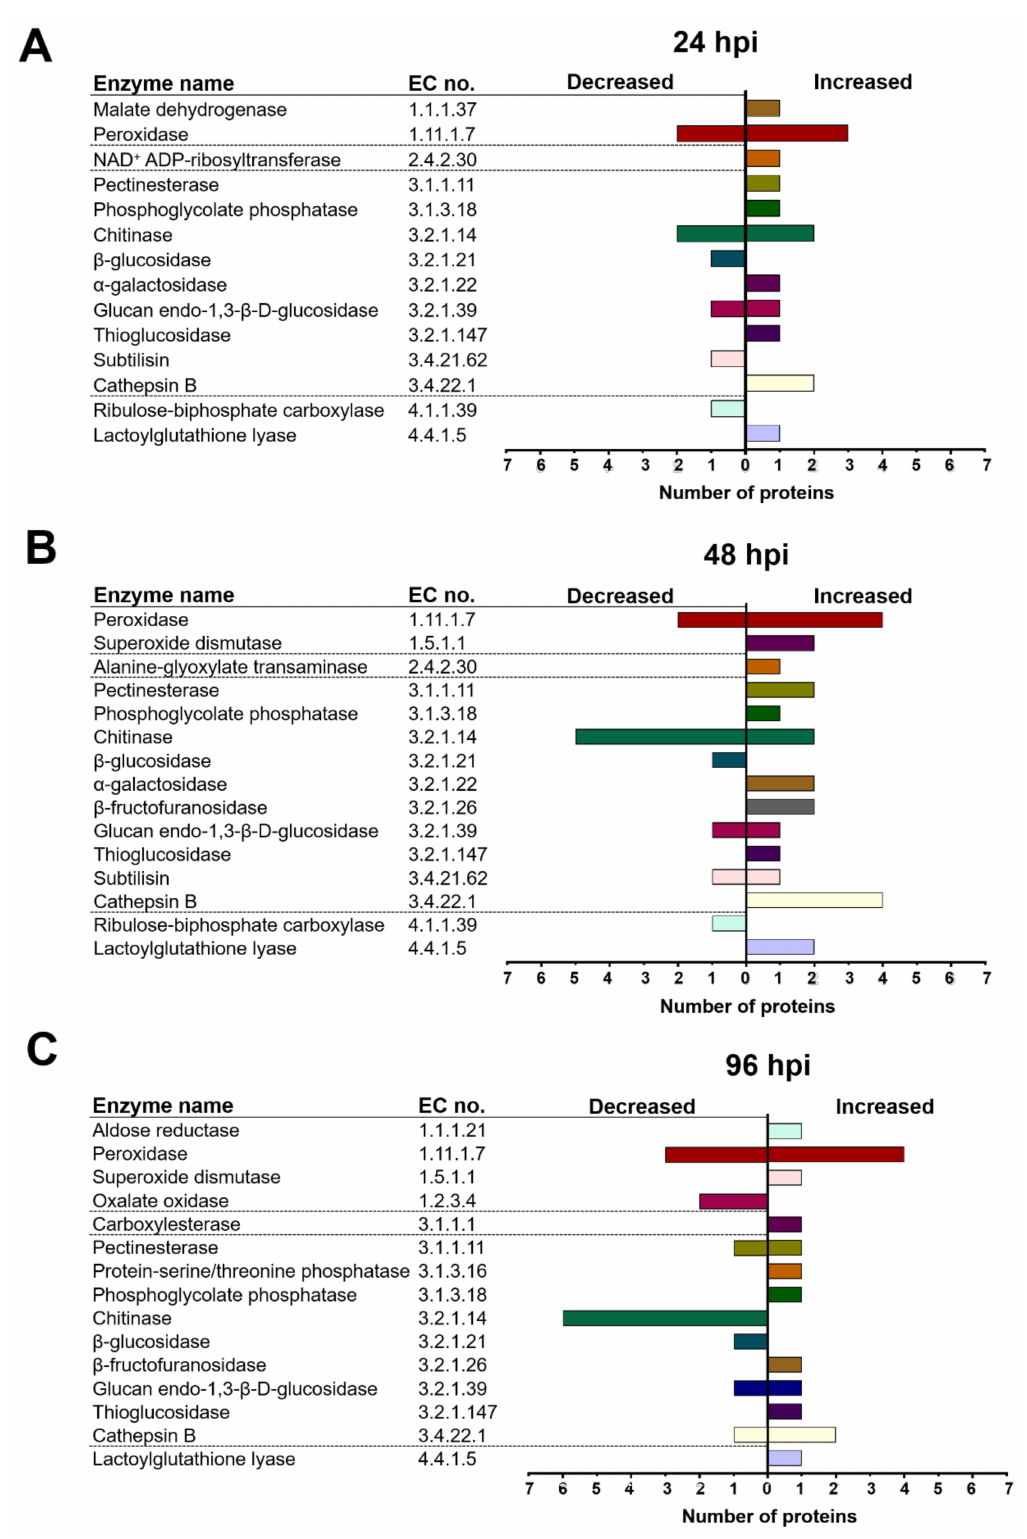
Figure 6. Arabidopsis responded to the presence of T. atroviride secreting mainly peroxidases and cathepsins B. ( A ) Enzymes identified in the Arabidopsis ’s secretome at 24 h, ( B ) 48 h, and ( C ) 96 h of interaction with T. atroviride. The classification was based on the enzyme activity prediction using BRENDA